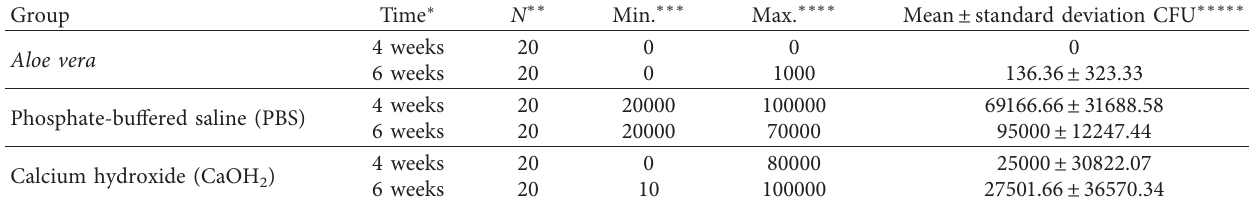
Table 1: Mean ± SD of the colony-forming unit of Enterococcus faecalis after treatment with different antimicrobial agents. Group Time